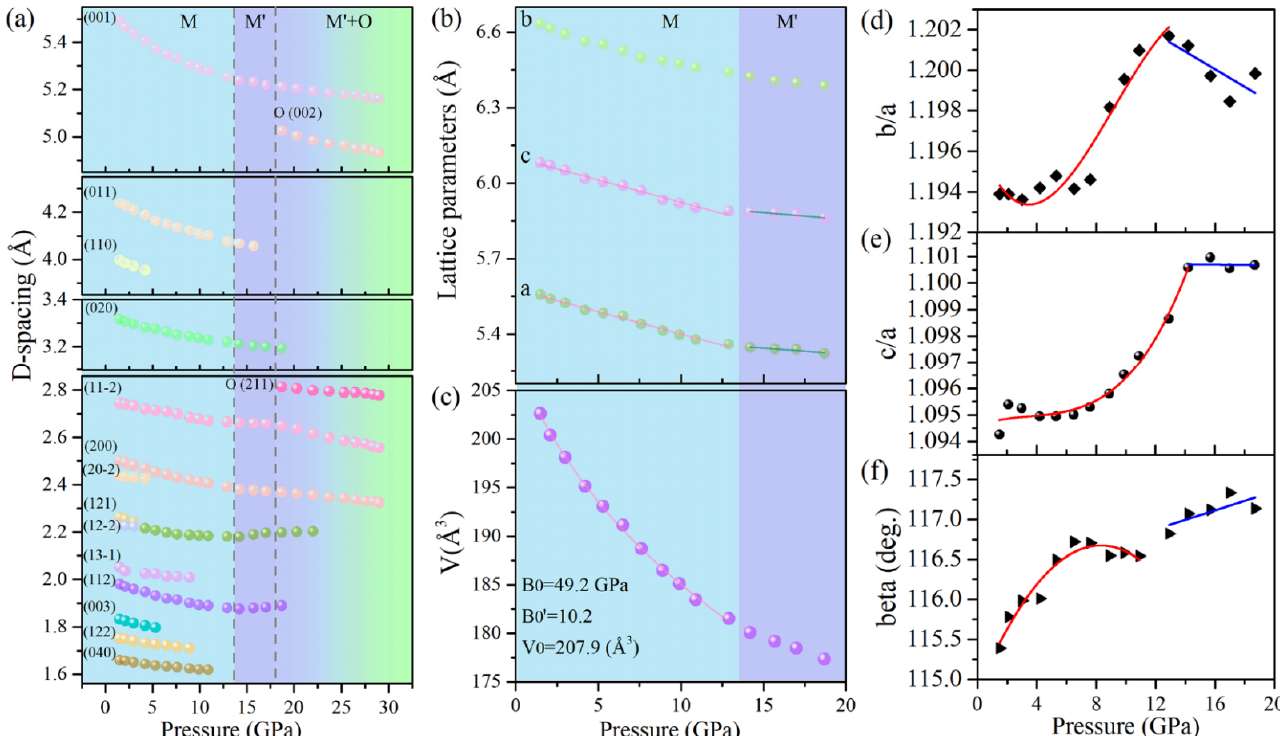
Figure 3. ( a ) The pressure-dependent d-spacings of Cu(OH)Cl. ( b ) The lattice parameters of Cu(OH)Cl as a function of pressure. ( c ) The pressure–volume relationship of Cu(OH)Cl. The spheres denote the experimental data points. They are fitted to the Birch–Murnaghan equation of state, as illustrated by the solid lines. ( d ) The evolution of the axial ratio b/a with pressure. ( e ) The evolution of the axial ratio c/a with pressure. ( f ) The evolution of the beta angle with pressure.